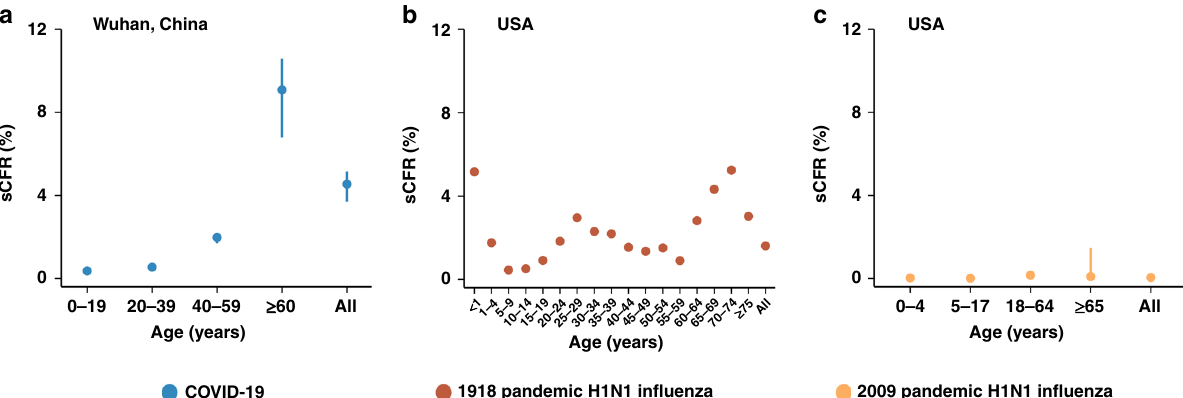
Fig. 5 Symptomatic case-fatality risk (sCFR). a sCFR associated with COVID-19 in Wuhan, China (mean, 95% CI). The error bars presented 95% CI as estimated using Monte Carlo sampling (10,000 samples from Binomial distributions). b sCFR associated with 1918 pandemic H1N1 in fl uenza